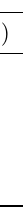
Table 2. Computational